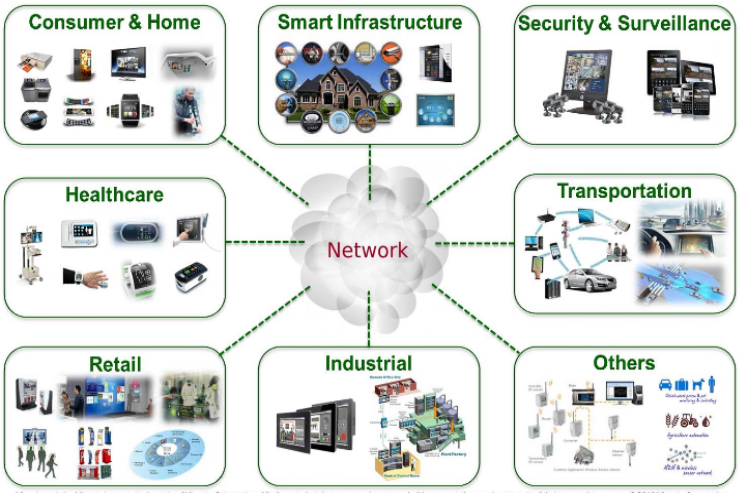
Figure 1. Consumer IoT